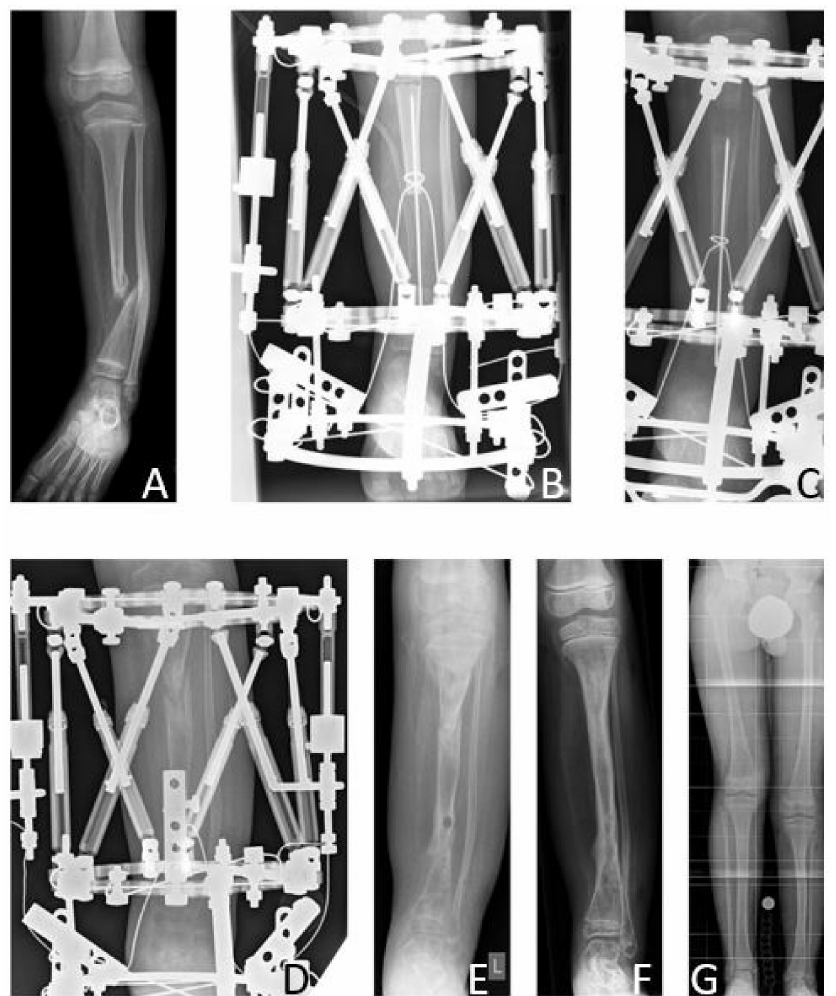
Figure 6. Results Group A. Seven-year-old male patient presenting CPT Paley type 3 ( A ). Bone transport was performed over a total distance of 50 mm ( B , C ). After bone docking ( D ) the external fixator was applied for another three months. After removal of the fixator ( E ), full bone consolidation was observed after 10 months ( F ). Five years after reconstruction, at the age of 13 years, the patient showed a remaining LLD of 2.8 cm ( G